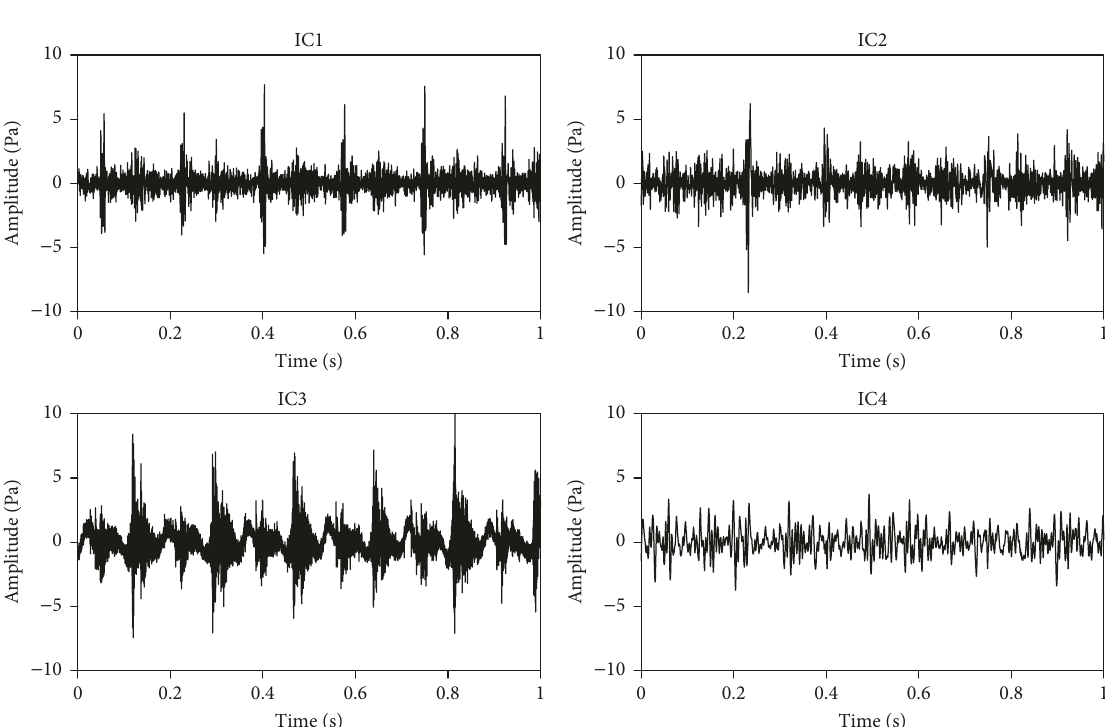
Figure 13: Calculation results of improved AIC.